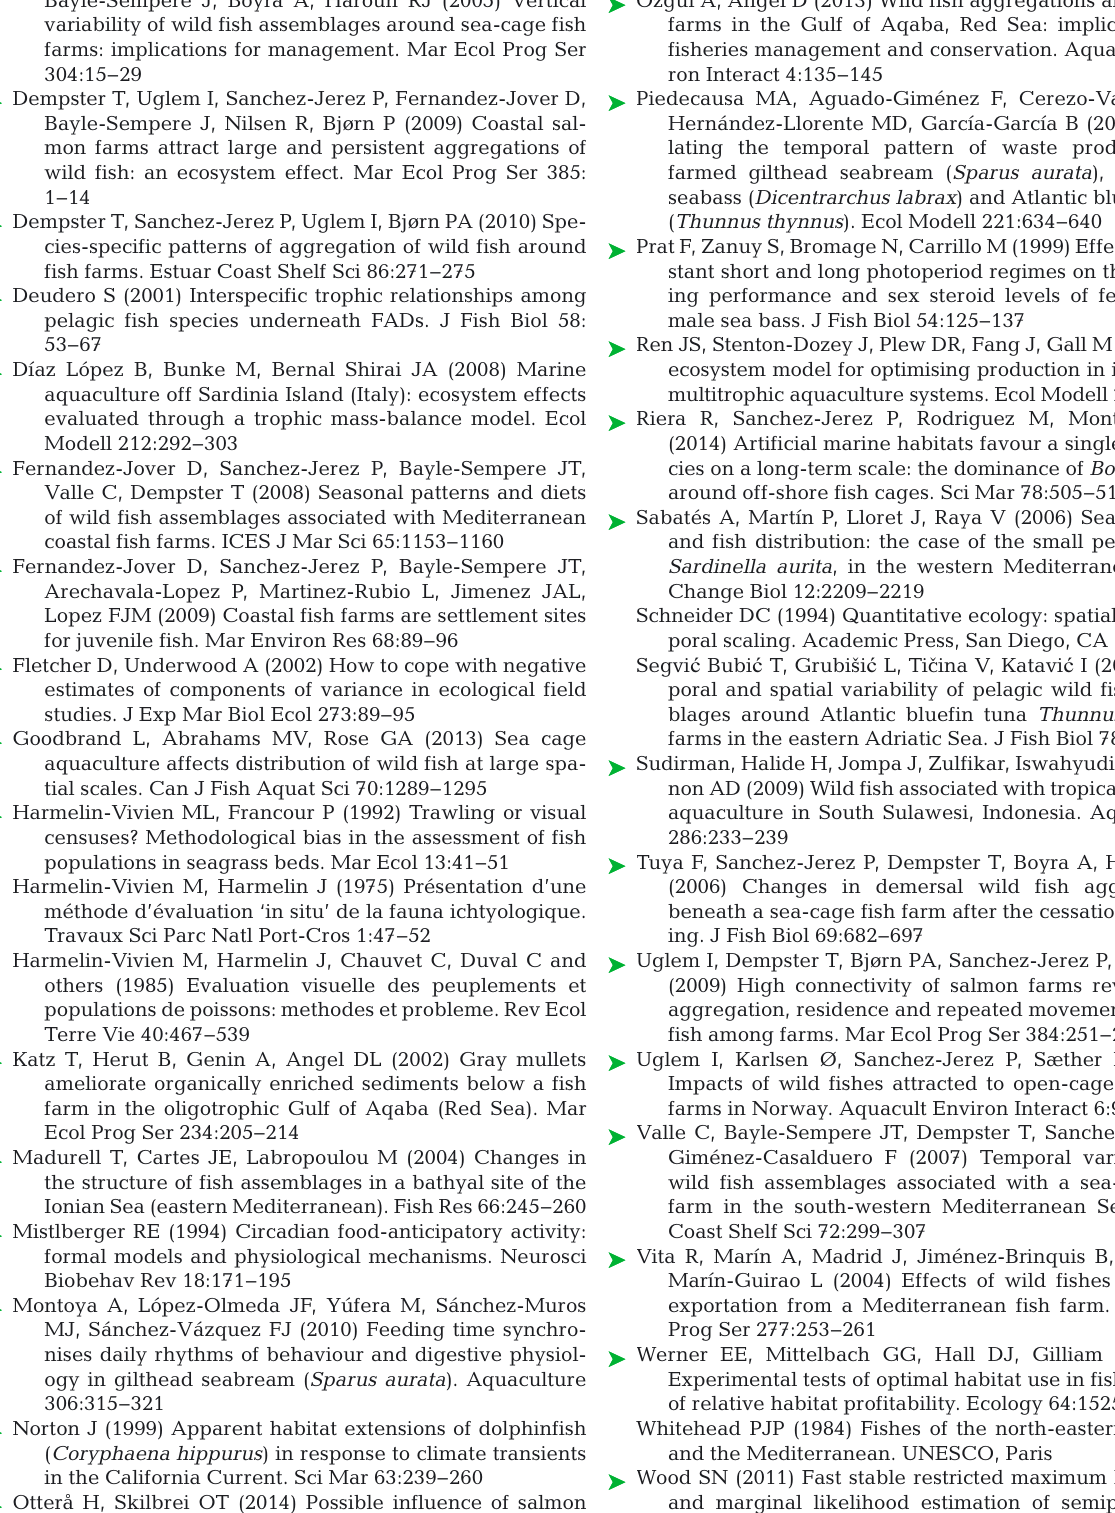
cies-specific patterns of aggregation of wild fish around fish farms. Estuar Coast Shelf Sci 86: 271−275 Deudero S (2001) Interspecific trophic relationships among pelagic fish species underneath FADs. J Fish Biol 58: 53−67 Díaz López B, Bunke M, Bernal Shirai JA (2008) Marine aquaculture off Sardinia Island (Italy): ecosystem effects evaluated through a trophic mass-balance model. Ecol Modell 212: 292−303 Fernandez-Jover D, Sanchez-Jerez P, Bayle-Sempere JT, Valle C, Dempster T (2008) Seasonal patterns and diets of wild fish assemblages associated with Mediterranean coastal fish farms. ICES J Mar Sci 65: 1153−1160 Fernandez-Jover D, Sanchez-Jerez P, Bayle-Sempere JT, Arechavala-Lopez P, Martinez-Rubio L, Jimenez JAL, Lopez FJM (2009) Coastal fish farms are settlement sites for juvenile fish. Mar Environ Res 68: 89−96 Fletcher D, Underwood A (2002) How to cope with negative estimates of components of variance in ecological field studies. J Exp Mar Biol Ecol 273: 89−95 Goodbrand L, Abrahams MV, Rose GA (2013) Sea cage aquaculture affects distribution of wild fish at large spa- tial scales. Can J Fish Aquat Sci 70: 1289−1295 Harmelin-Vivien ML, Francour P (1992) Trawling or visual censuses? Methodological bias in the assessment of fish populations in seagrass beds. Mar Ecol 13: 41−51 Harmelin-Vivien M, Harmelin J (1975) Présentation d’une méthode d’évaluation ‘in situ’ de la fauna ichtyologique. Travaux Sci Parc Natl Port-Cros 1: 47−52 Harmelin-Vivien M, Harmelin J, Chauvet C, Duval C and others (1985) Evaluation visuelle des peuplements et populations de poissons: methodes et probleme. Rev Ecol Terre Vie 40: 467−539 Katz T, Herut B, Genin A, Angel DL (2002) Gray mullets ameliorate organically enriched sediments below a fish farm in the oligotrophic Gulf of Aqaba (Red Sea). Mar Ecol Prog Ser 234: 205−214 Madurell T, Cartes JE, Labropoulou M (2004) Changes in the structure of fish assemblages in a bathyal site of the Ionian Sea (eastern Mediterranean). Fish Res 66: 245−260 Mistlberger RE (1994) Circadian food-anticipatory activity: formal models and physiological mechanisms. Neurosci Biobehav Rev 18: 171−195 Montoya A, López-Olmeda JF, Yúfera M, Sánchez-Muros MJ, Sánchez-Vázquez FJ (2010) Feeding time synchro- nises daily rhythms of behaviour and digestive physiol- ogy in gilthead seabream ( Sparus aurata ). Aquaculture 306: 315−321 Norton J (1999) Apparent habitat extensions of dolphinfish ( Coryphaena hippurus ) in response to climate transients in the California Current. Sci Mar 63: 239−260 Otterå H, Skilbrei OT (2014) Possible influence of salmon farming on long-term resident behaviour of wild saithe ( Pollachius virens L.). ICES J Mar Sci 9: 2484−2493